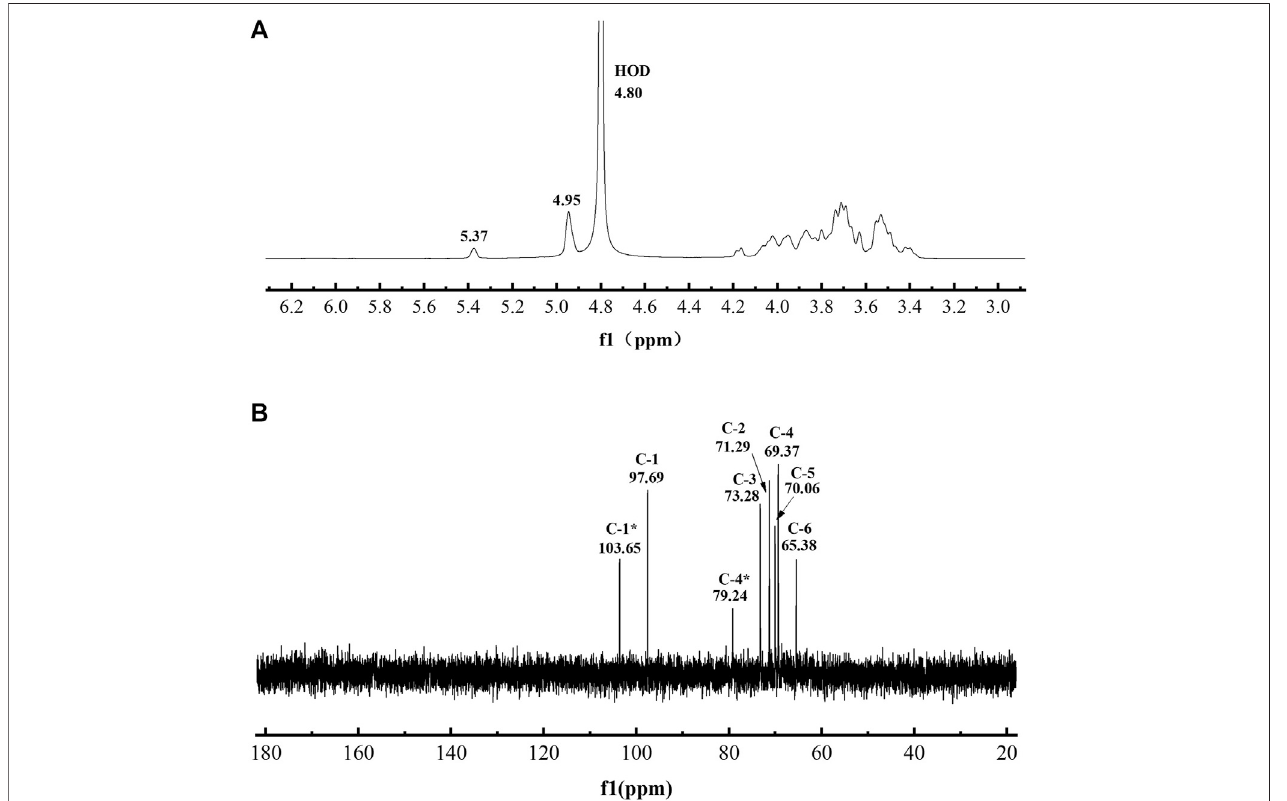
FIGURE 5 | The spectra of puri fi ed L-dextran synthesized by mutant Q634A. (A) 1H NMR spectra (B) 13C NMR spectra.